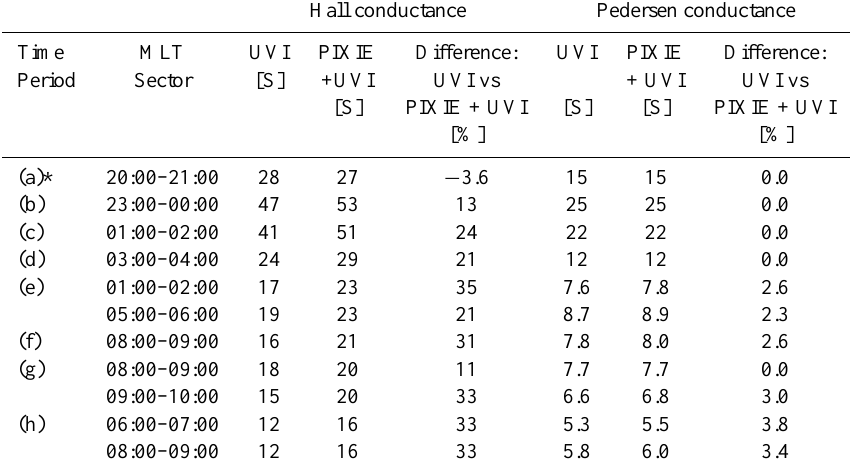
Table 1. Maximum Hall and Pedersen conductance in magnitude and location for the isolated substorm event on 31 July 1997, as derived from the combined PIXIE and UVI measurements as well as from UVI data only. We also present the differences in percent between the conductance values using electron spectra derived from both PIXIE and UVI compared with the values obtained using spectra derived from UVI only. The letters a–h correspond to the 8 time periods as given in Fig.